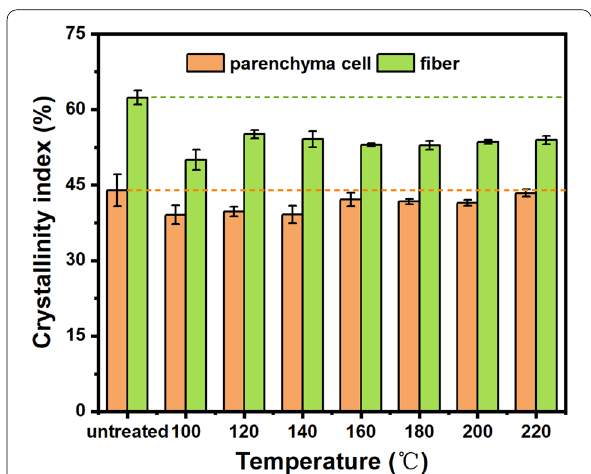
Fig. 9 The crystallinity index of cellulose in parenchyma cells and